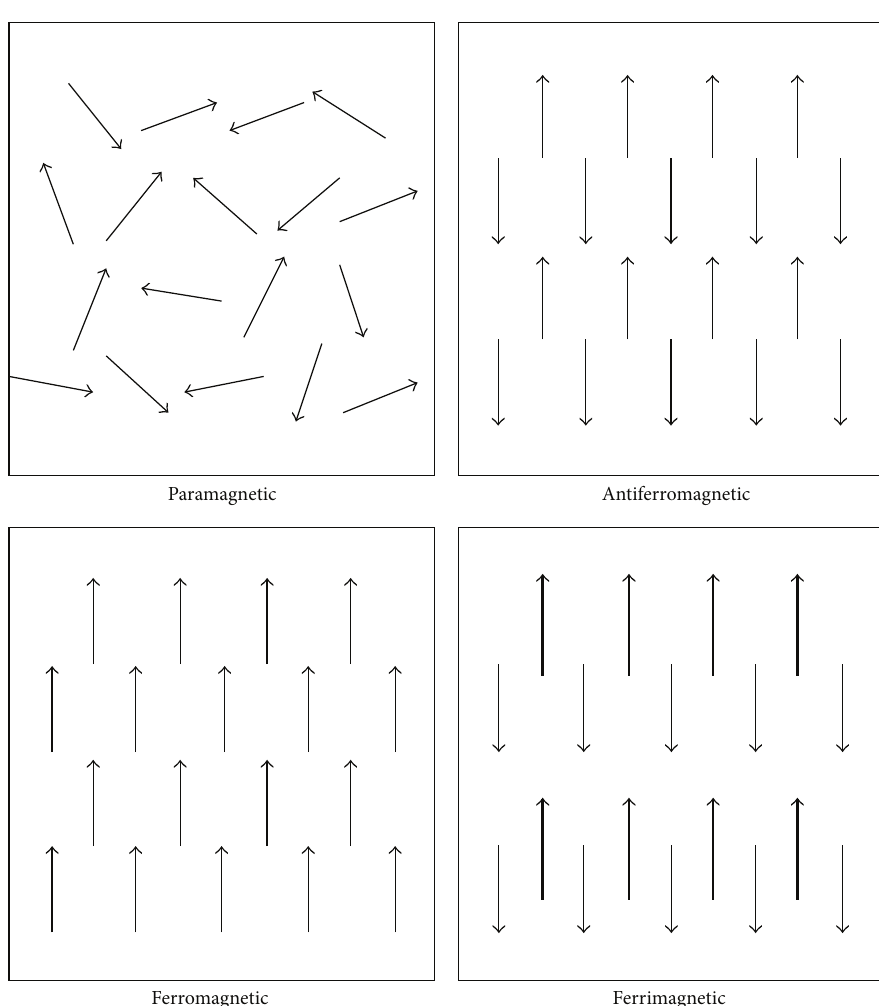
Figure 3: The statement of moment orientation in different magnetic structures such as paramagnetic, ferromagnetic, ferrimagnetic, and antiferromagnetic structures